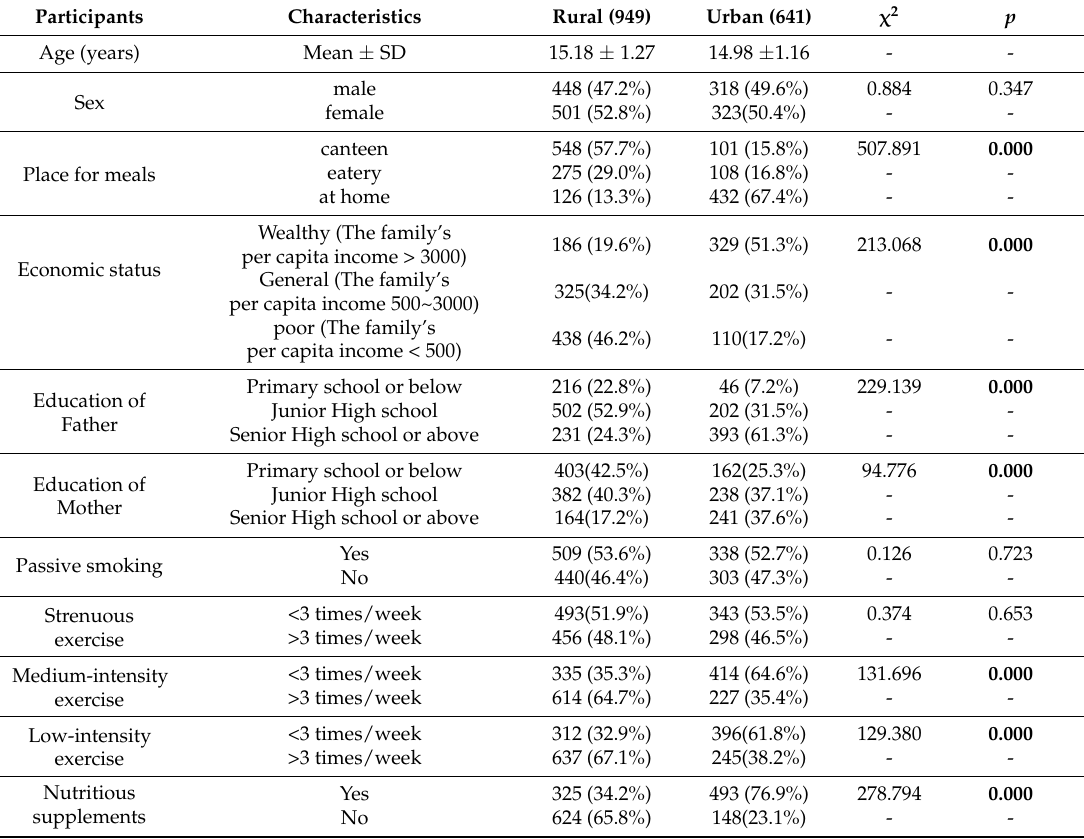
Table 2. Rural-urban characteristics of the study